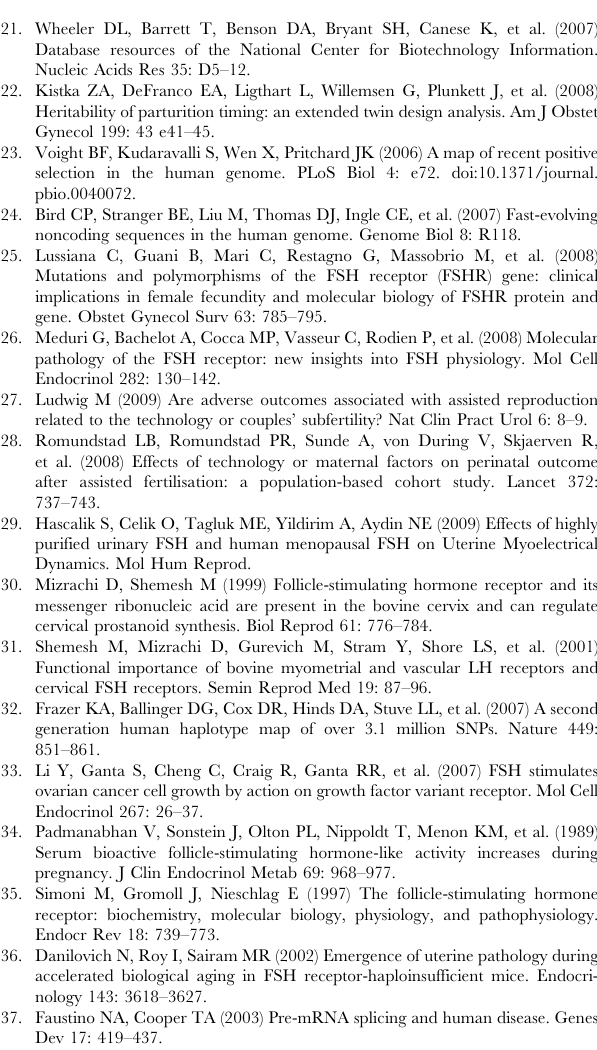
Figure S4 Venn diagram illustrating the overlap between the results of our noncoding analysis and similar studies. Unique genes identified by Pollard et al. [11] and Prabhakar et al. [20] are compared to genes we identified as accelerated on the human lineage (10% FDR). Table S1 List of species used in allometric analysis. Found at: doi:10.1371/journal.pgen.1001365.s007 (0.02 MB Table S2 Candidate human accelerated genes examined for association with preterm birth. Table S3 SNPs in the human accelerated gene regions tested with p-values , 0.01 in the Finnish cohort. Table S4 SNPs in the FSHR gene region tested across Finnish and 3 independent US populations.